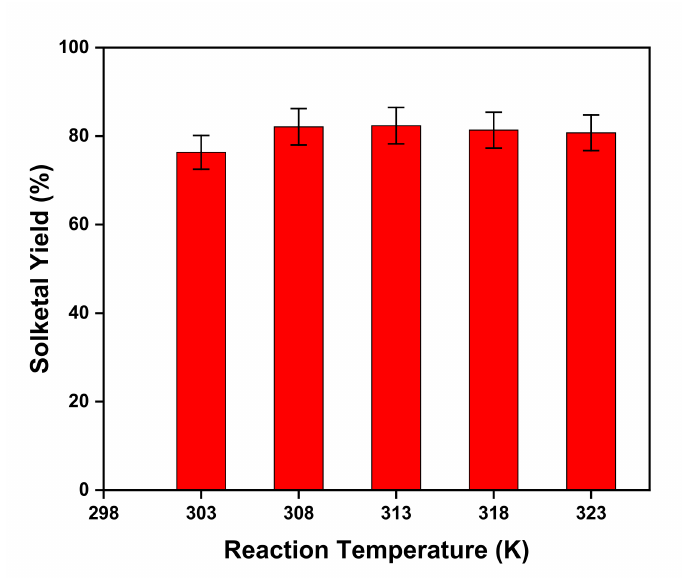
Figure 5. Influence of reaction temperature on the ketalization reaction of